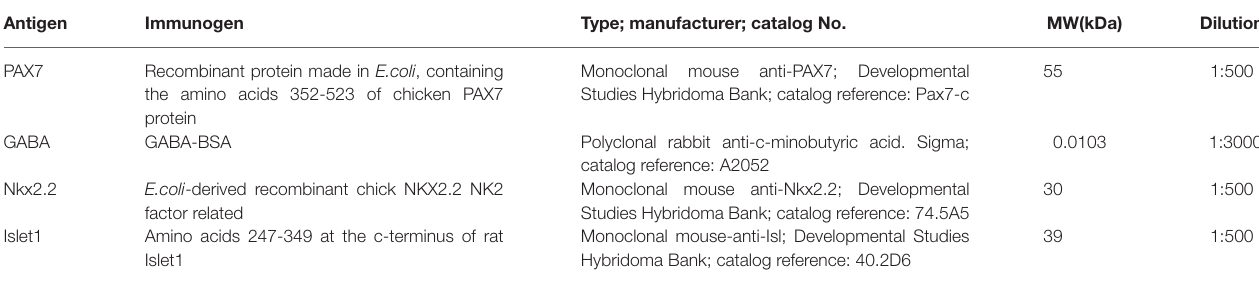
TABLE 3 | List of antibodies used in the present study.